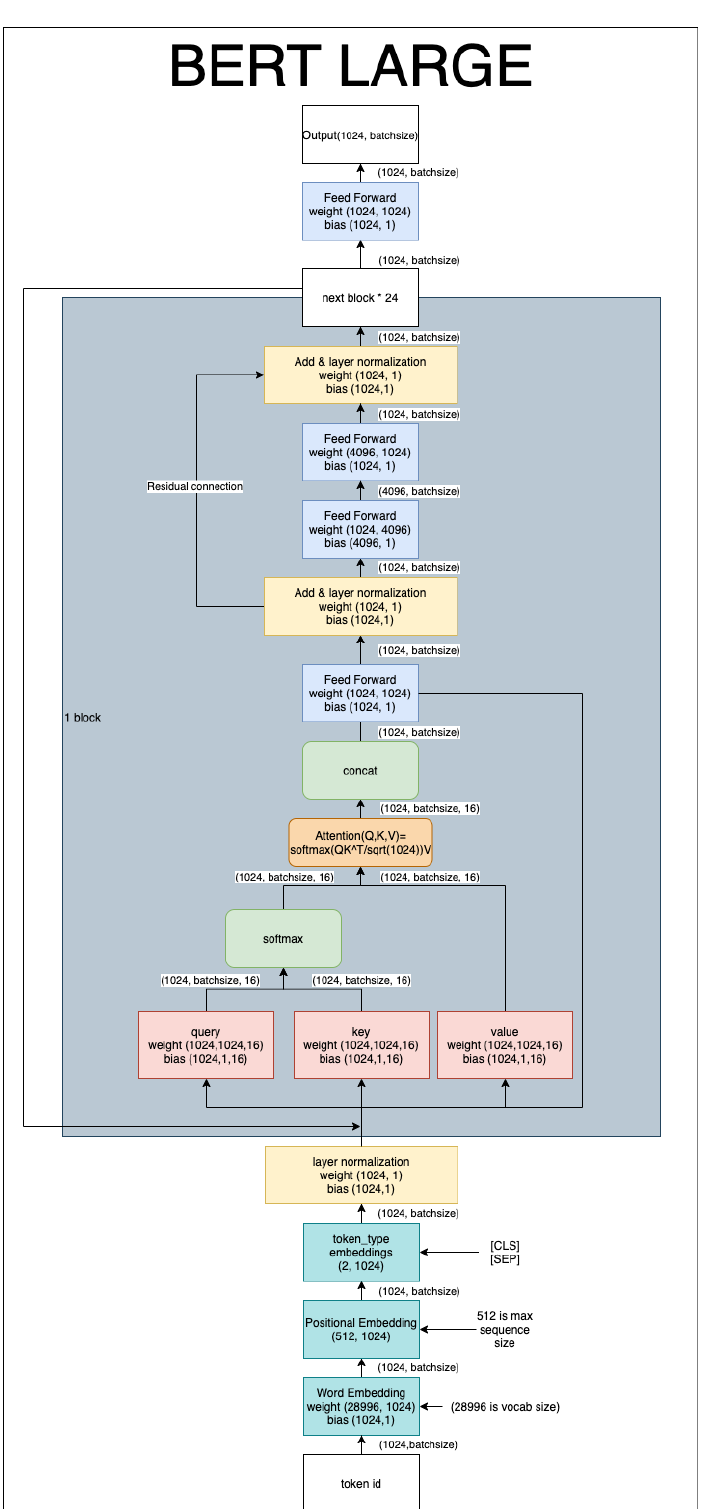
Figure 3. In the BERT Large model, the numbers next to the weight and bias indicate the size of the tensor, and the numbers with arrows indicate the size of the tensor flowing through